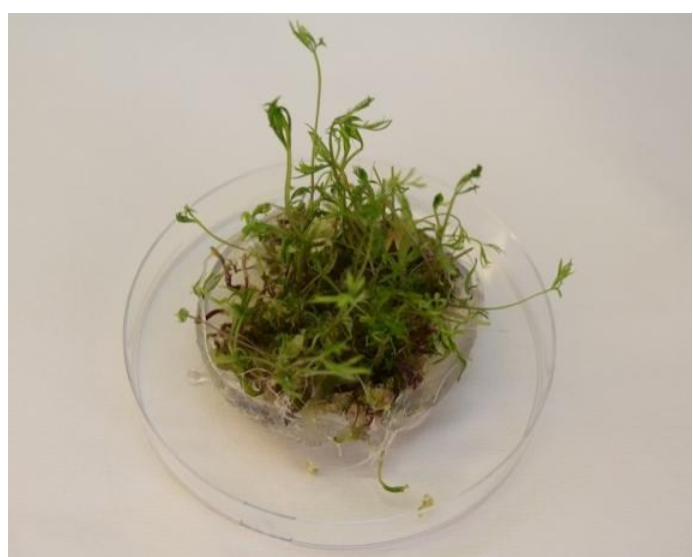
Figure 16. Seedlings of Polignano carrot obtained by micropropagation (Photo credit: Claudia Ruta - from https://biodiversitapuglia.it).